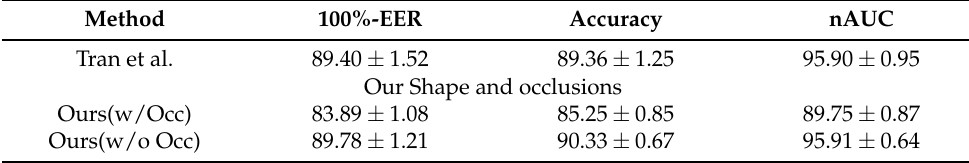
Table 2. Quantitative comparison on